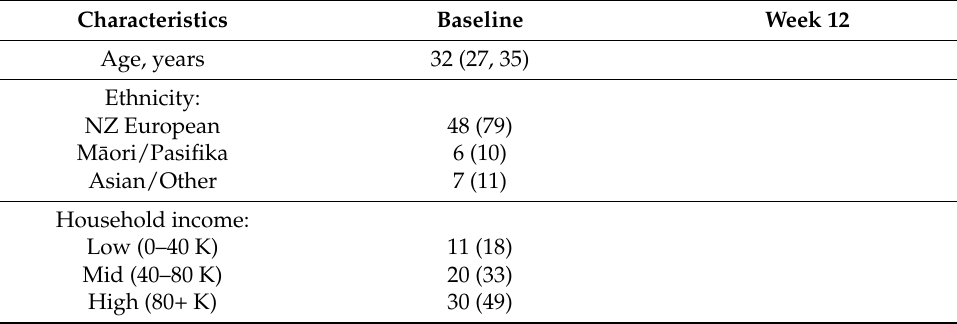
Table 1. Participant characteristics at baseline and week 12 ( n =